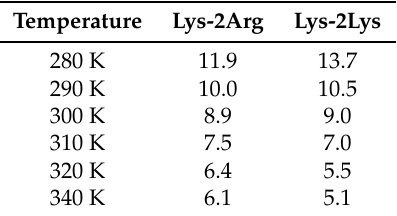
(ns) of the Lys-2Arg and Lys-2Lys rot